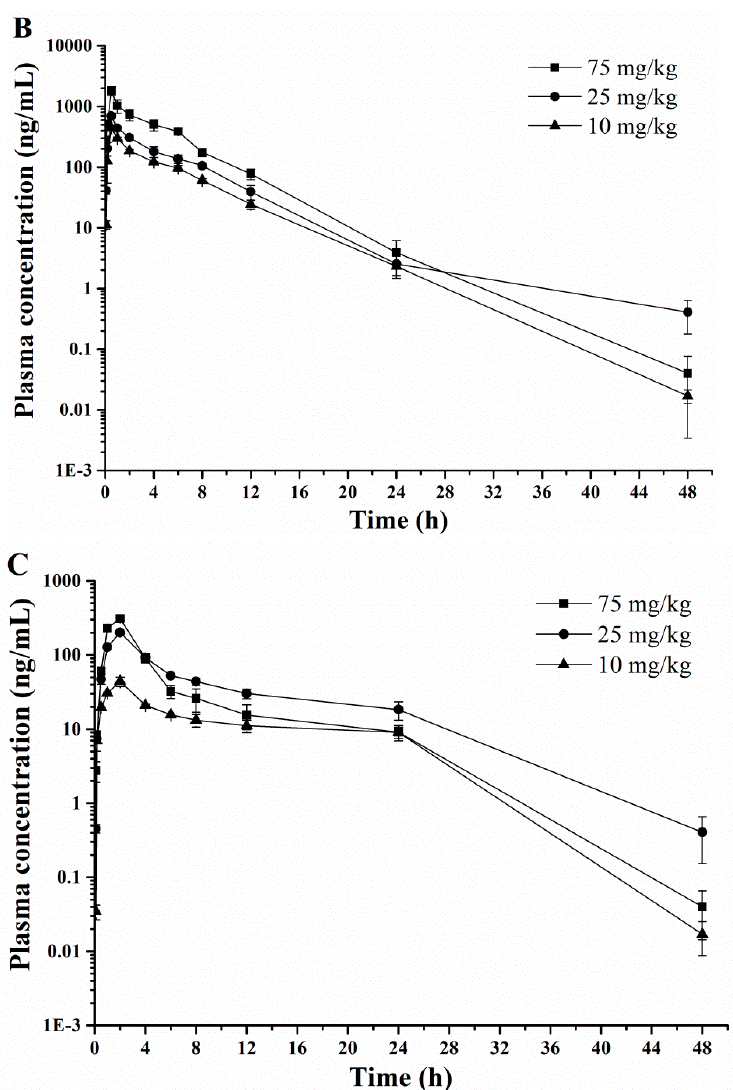
Figure 3. Plasma concentration-time curve of DPTM after i.v. ( A ), i.m. ( B ) and p.o. ( C ) administration to rats.